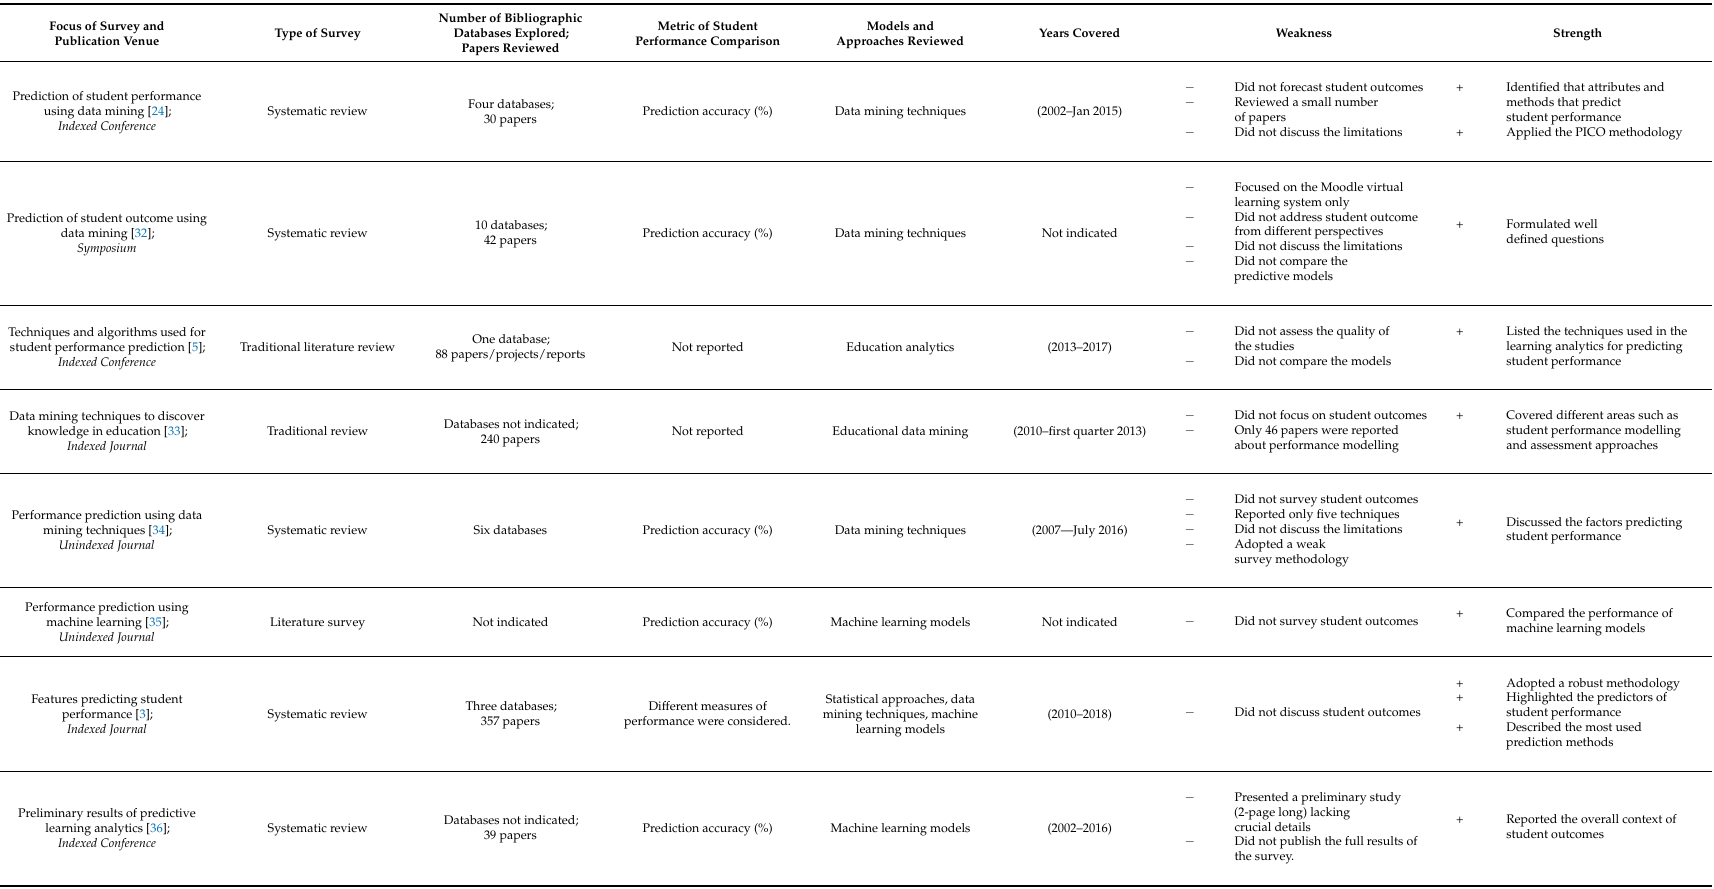
Table 1. Existing surveys on student performance prediction, their weaknesses and